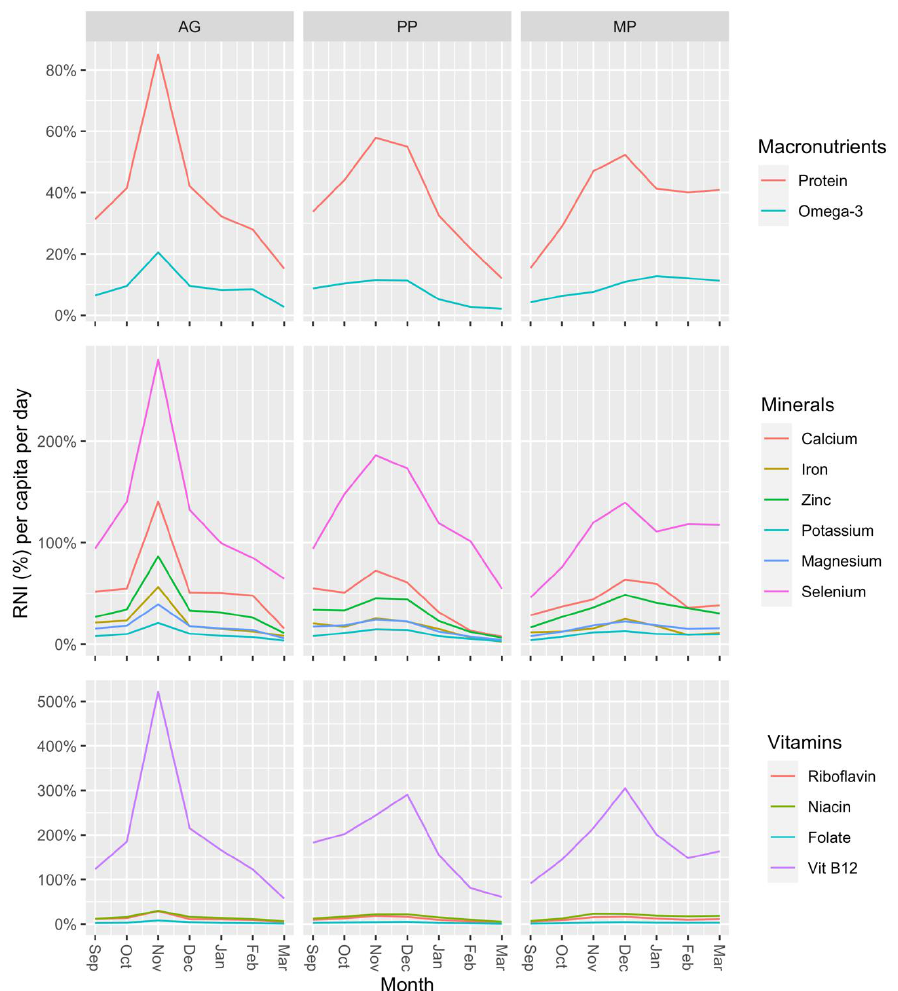
Figure 6. The percentage of the recommended nutrient intake (RNI) reached per capita per day of selected nutrients: minerals, vitamins, and omega-3 fatty acids derived from the consumption of fish over 6 months (September 2019 – March 2020), disaggregated according to the three study groups.